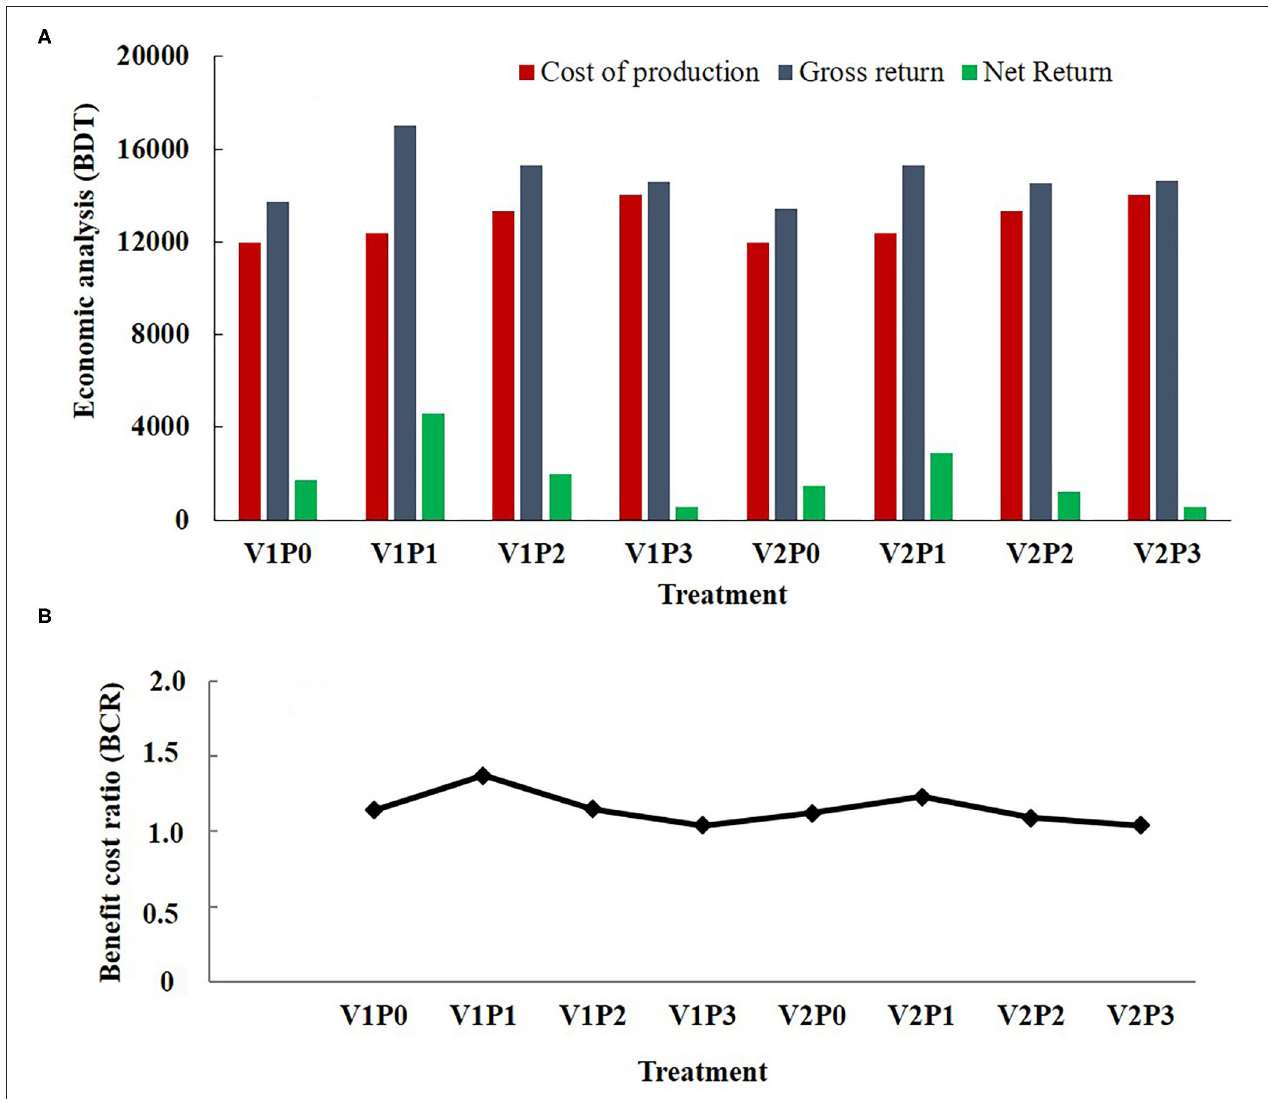
FIGURE 4 | (A) Economic analysis and (B) Benefit cost ratio of two lettuce cultivars ( Lactuca sativa cv. Green Wave, V1; Lactuca sativa cv. New Red Fire, V2) vertically grown in different organic growing media (P0: control, 100% soil; P1: 40% soil + 40% vermicompost + 20% cocodust; P2: 50% soil + 50% vermicompost; P3: 20% soil + 40% vermicompost + 40% spent mushroom compost) on the wall of a building in Dhaka City, Bangladesh.